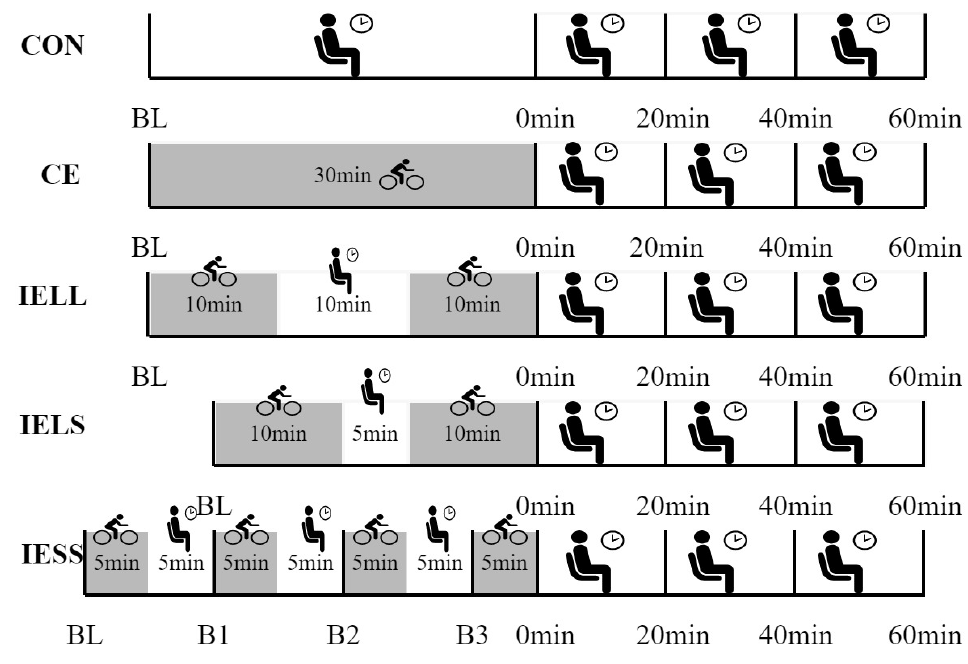
Figure 1. Exercise time, intervals, and measurement study methods for five trials: CON (control trial), CE (one 30 min session), IELL (two repeats of 10 min cycling sessions with a 10 min pause between sessions), IELS (two repeats of 10 min cycling sessions with a 5 min pause between sessions), and IESS (four repeats of 5 min cycling sessions with a 5 min pause between sessions). In CE, IELL, IELS. and IESS tests, the measured time points were baseline (BL), immediate (0 min), 20 min, 40 min, and 60 min after exercise. Additionally, three additional baPWV measures were